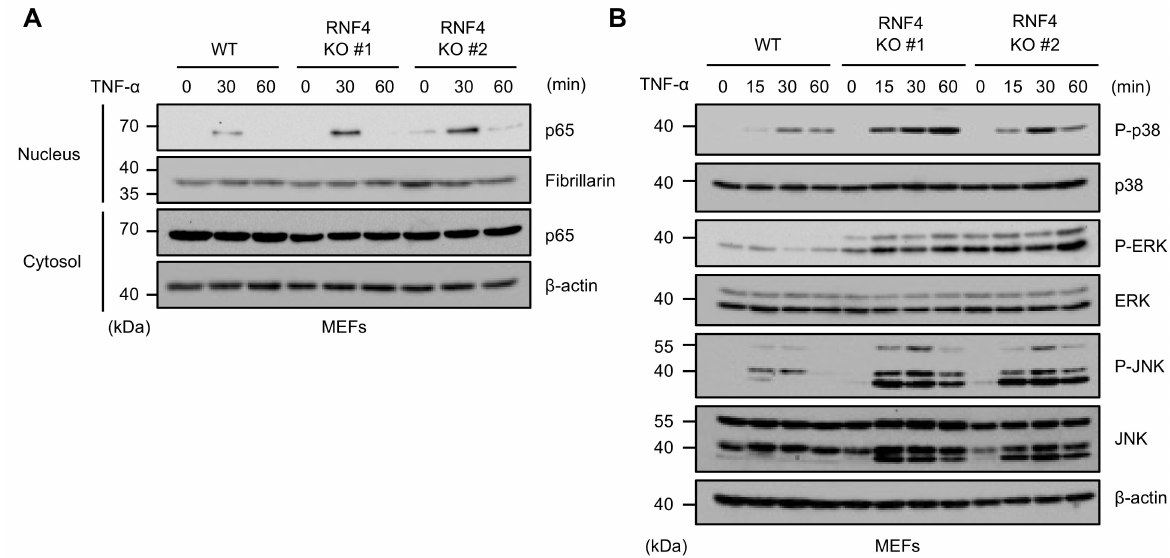
Figure 3. RNF4 suppresses TNF- α -induced activation of the NF- κ B and MAPK signaling pathways. ( A ) TNF- α -induced nuclear translocation of p65 in RNF4 KO MEFs. MEFs were treated with TNF- α (50 ng/mL) for the indicated periods. The nuclear and cytoplasmic extracts were subjected to immunoblotting with the indicated antibodies. β -actin (Cytosol) and Fibrillarin (Nucleus) were used as a loading control. ( B ) TNF- α -induced activation of the MAPK signaling pathways in RNF4 KO MEFs. MEFs were treated with TNF- α (50 ng/mL) for the indicated periods. Cell lysates were subjected to immunoblotting with the indicated antibodies. β -actin was used as a loading control. All data are representative of at least three independent